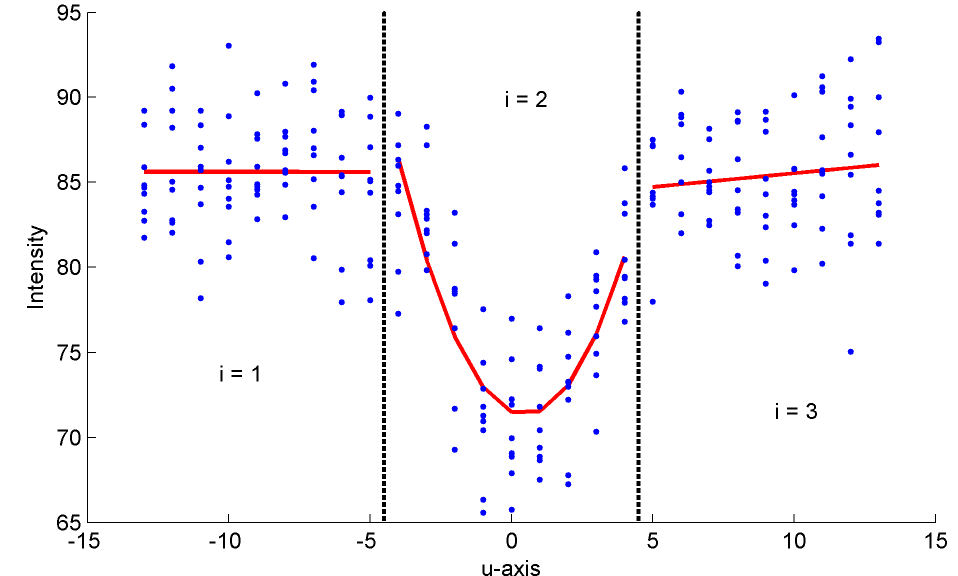
Figure 6. Gray level profile of pixels along the direction of the line. The red line is the result of the fit in the three regions, which are separated by dashed